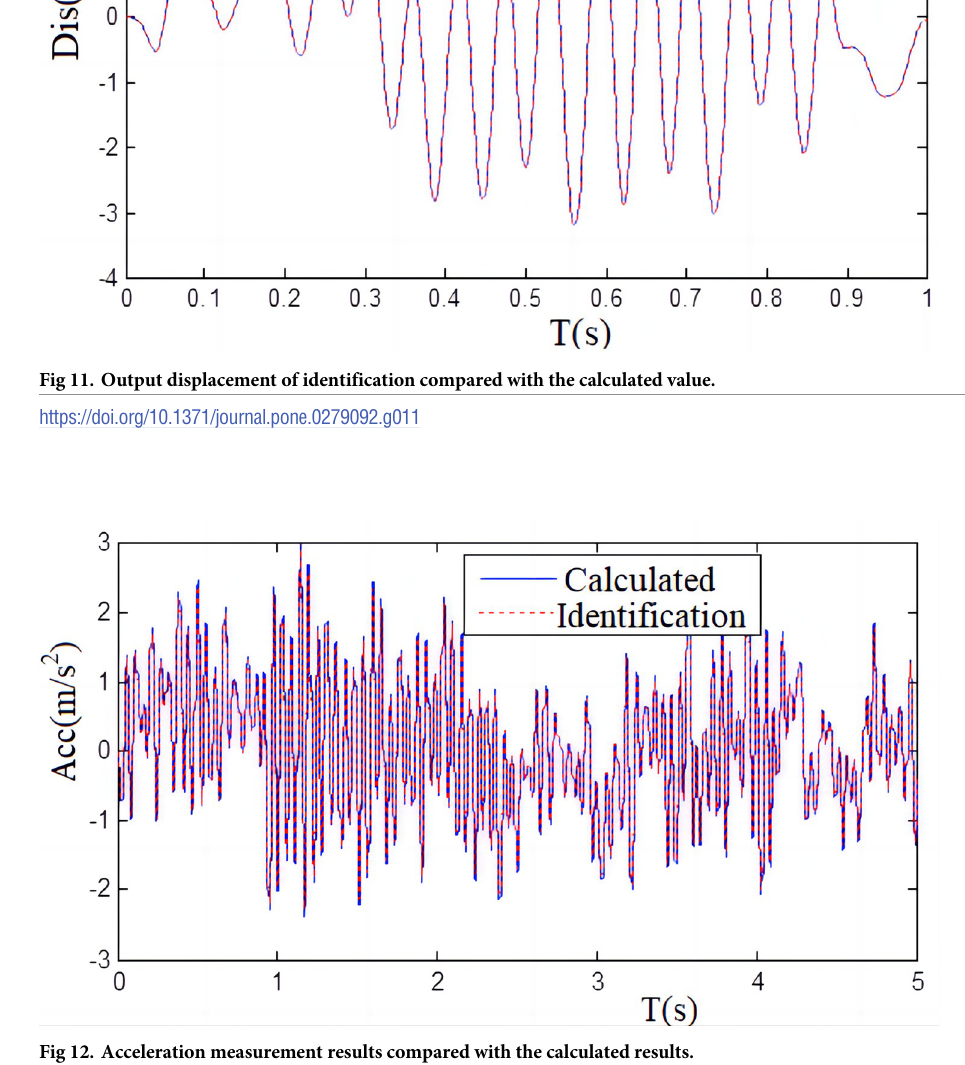
Fig 12. Acceleration measurement results compared with the calculated